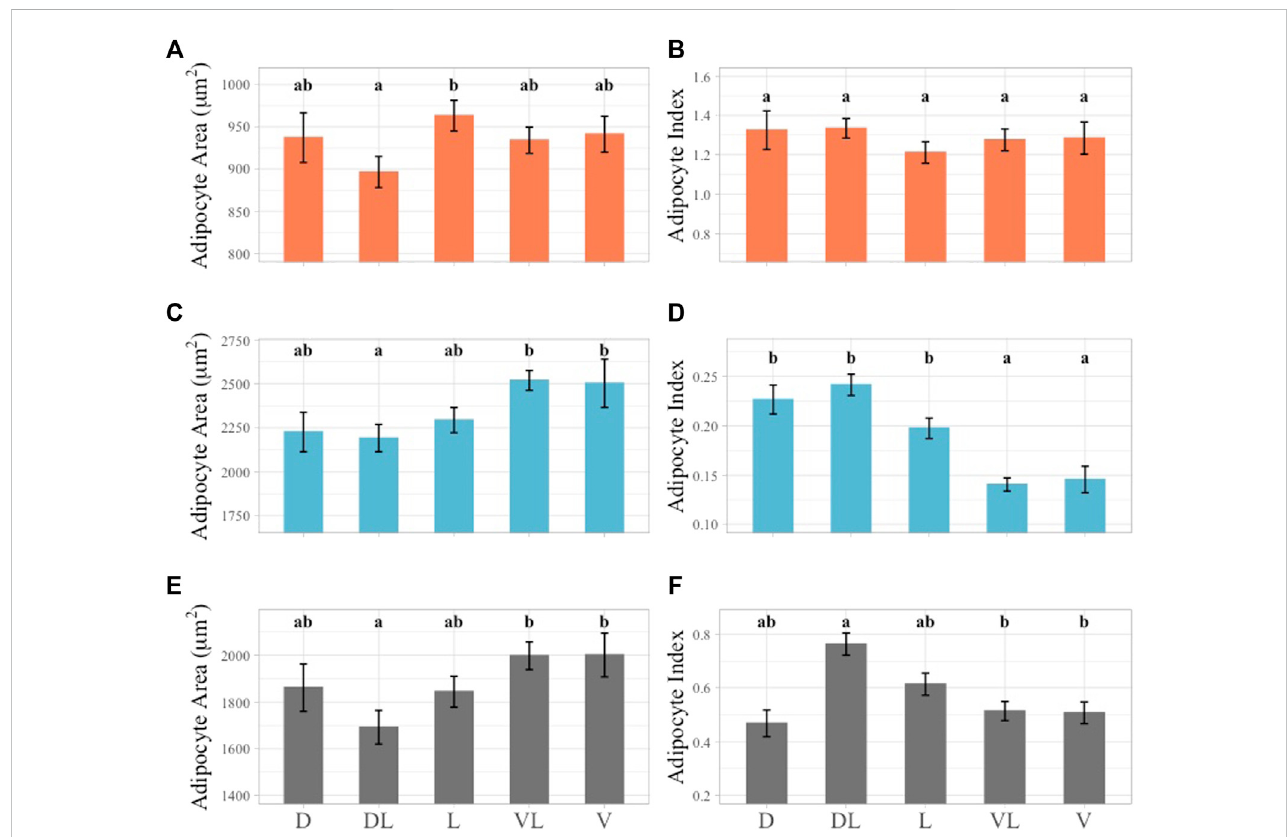
FIGURE 7 Linear mixed effect model of average AA and AI across sampling planes subset by layer. Outer layer data shown in orange at top row of fi gure panel, middle layer shown in blue in middle row of fi gure panel, inner layer shown in gray in bottom row of fi gure panel. Signi fi cant differences identi fi ed by lower case letters above each bar graph. Groups with any shared letters are not signi fi cantly different to each other. Error bars represent standard error. (A) Outer layerAA, (B) OuterLayerAI, (C) MiddlelayerAA, (D) MiddleLayerAI, (E) InnerlayerAA, (F) InnerLayerAI.Samplingplaneforallplotsshownusing1-2letter identi fi er along X -axis of inner layer Panel 7E, F, “ D ” = Dorsal, “ DL ” = Dorsolateral, “ L ” = Lateral, “ VL ” = Ventrolateral, “ V ” =